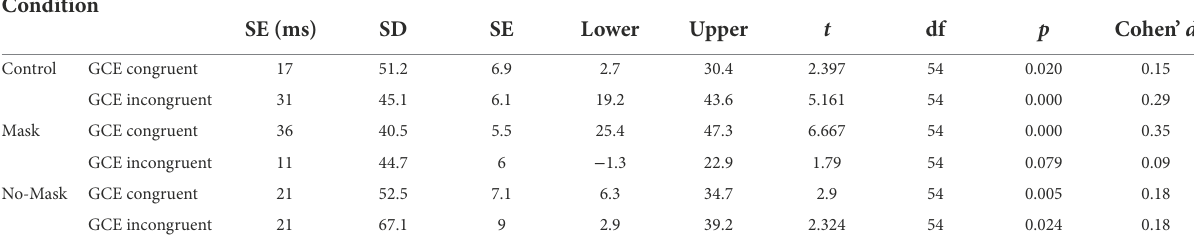
TABLE 2 Paired simple t-test comparing Simon effect (i.e., Non-corresponding vs. Corresponding trials) in GCE Incongruent and congruent trials for each experimental condition (i.e., Control, Mask, No-Mask).